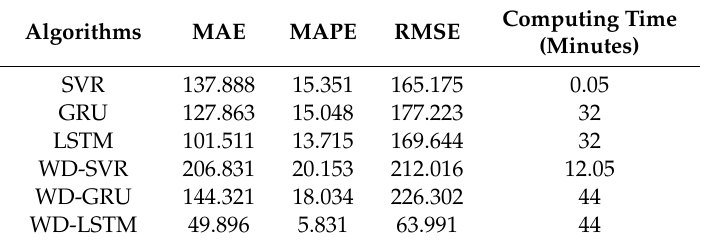
Table 3. Comparison of prediction performances using machine learning and deep learning